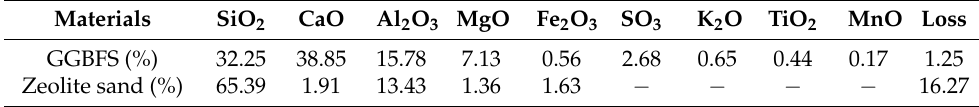
Table 1. Chemical compositions of the slag and zeolite